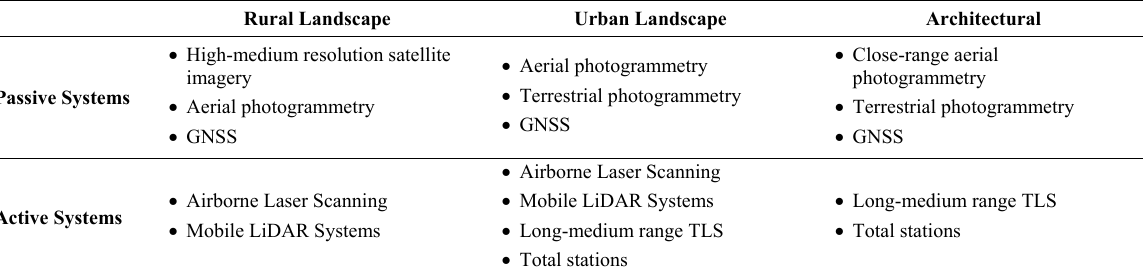
Table 2. Set of geotechnologies appropriate to 3D data acquisition in CH environments classified according to the dimensions of the element or site under study.